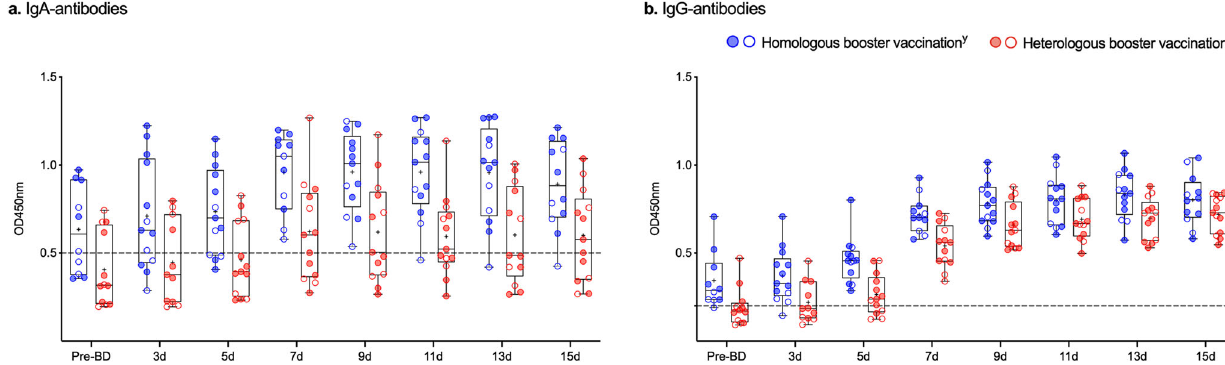
Fig. 2 SARS-CoV-2-speci fi c antibodies in human milk after COVID-19 booster vaccination in lactating women. Antibody responses in human milk before and after homologous and heterologous booster vaccination are shown in box-and-whisker plots of SARS-CoV-2-speci fi c immunoglobulin A ( a ) and immunoglobulin G ( b ). Blue dots (y) represent participants who received an mRNA-based vaccine for their primary series: two doses of mRNA-1273 (blue- fi lled dots) or BNT162b2 (transparent dots, blue border). Red dots (z) represent participants who received an adenoviral vector-based vaccine as primary series: two doses of AZD1222 (red- fi lled dots) or a single dose of Ad26.COV2.S (transparent dots, red border). For each group, n = 13 biologically independent samples except for the following days in the heterologous booster group prior to booster dose ( n = 12) and after 3 days ( n = 11), and in the homologous booster group prior to booster dose ( n = 10), after 7 days ( n = 11), and 15 days ( n = 12). All scatter plots in this fi gure represent the mean of measurements in duplicate per participant. Analyzed samples were collected before (Pre-BD), and 3 days (3d), 5 days (5d), 7 days (7d), 9 days (9d), 11 days (11d), 13 days (13d), and 15 days (15d) after administration of an mRNA-vaccine booster dose (BD). Boxes indicate the 25th percentile, median (horizontal bar), mean ( “ + ” ), and 75th percentile; whiskers, minimum and maximum ranges; OD450nm, optical density 450 nm. Cutoff values are indicated with dashed lines. Source data are provided in the Supplementary Data 1 fi